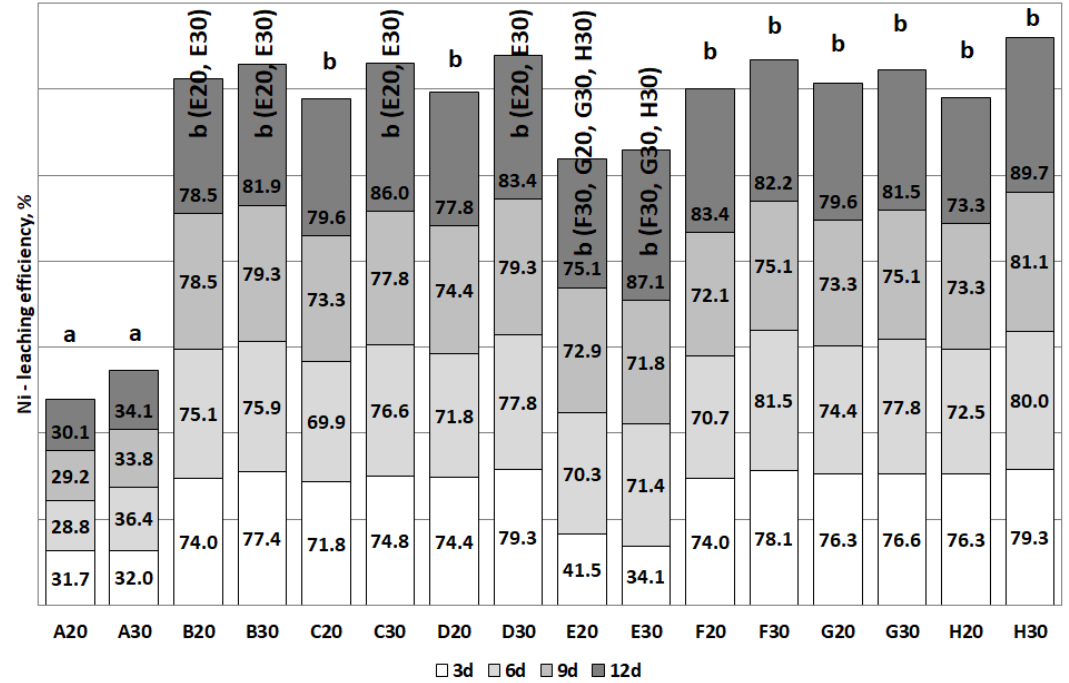
Figure 13. Bioleaching efficiency of Mn during the experiment (Statistical groups a and b ).